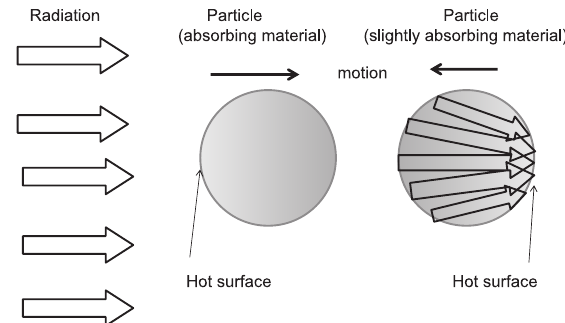
Fig. 3 Explanation of positive and negative photophoresis (Rubinowitz, 1920). The surface of a strongly absorb- ing particle is hotter on the side facing the radiation, thus photophoresis is in the direction of the radiation. A particle that slightly absorbs light focuses the light to the rear side, which consequently is hotter, thus the particle moves in the opposite